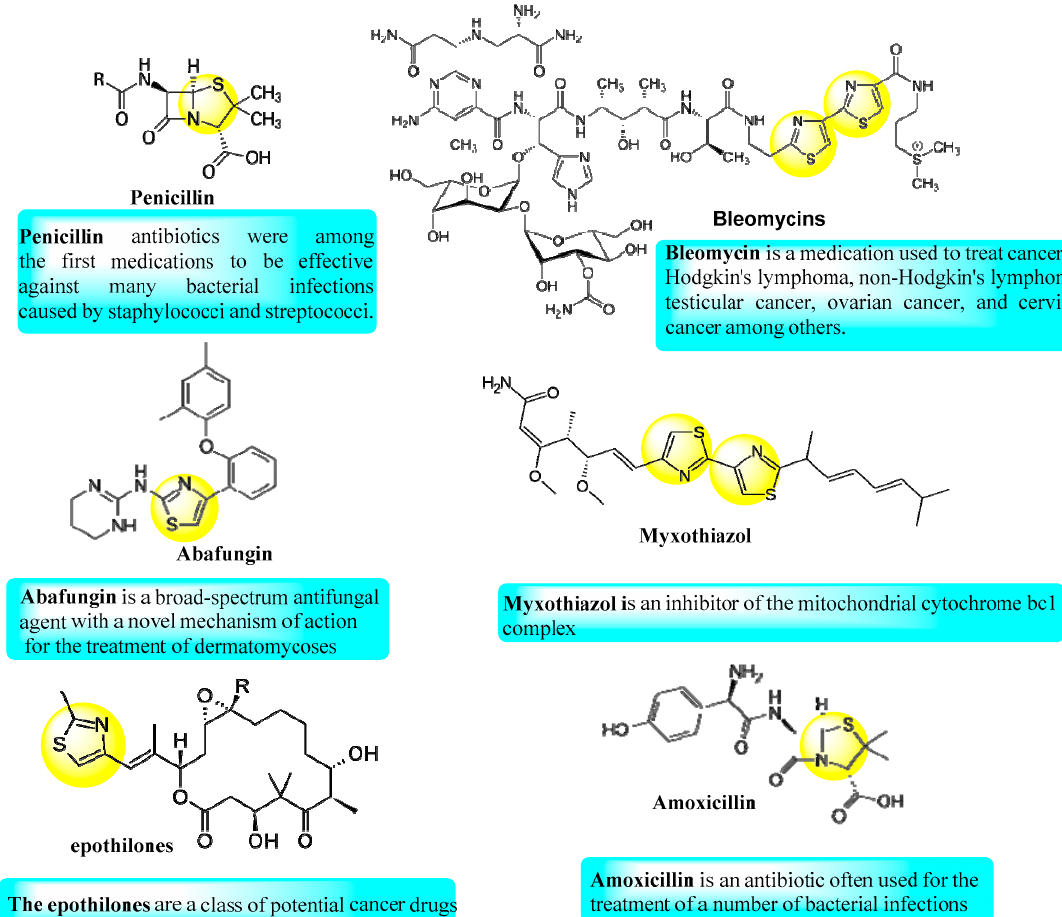
Figure 1. Natural and available marketing drugs containing thiazole rings.